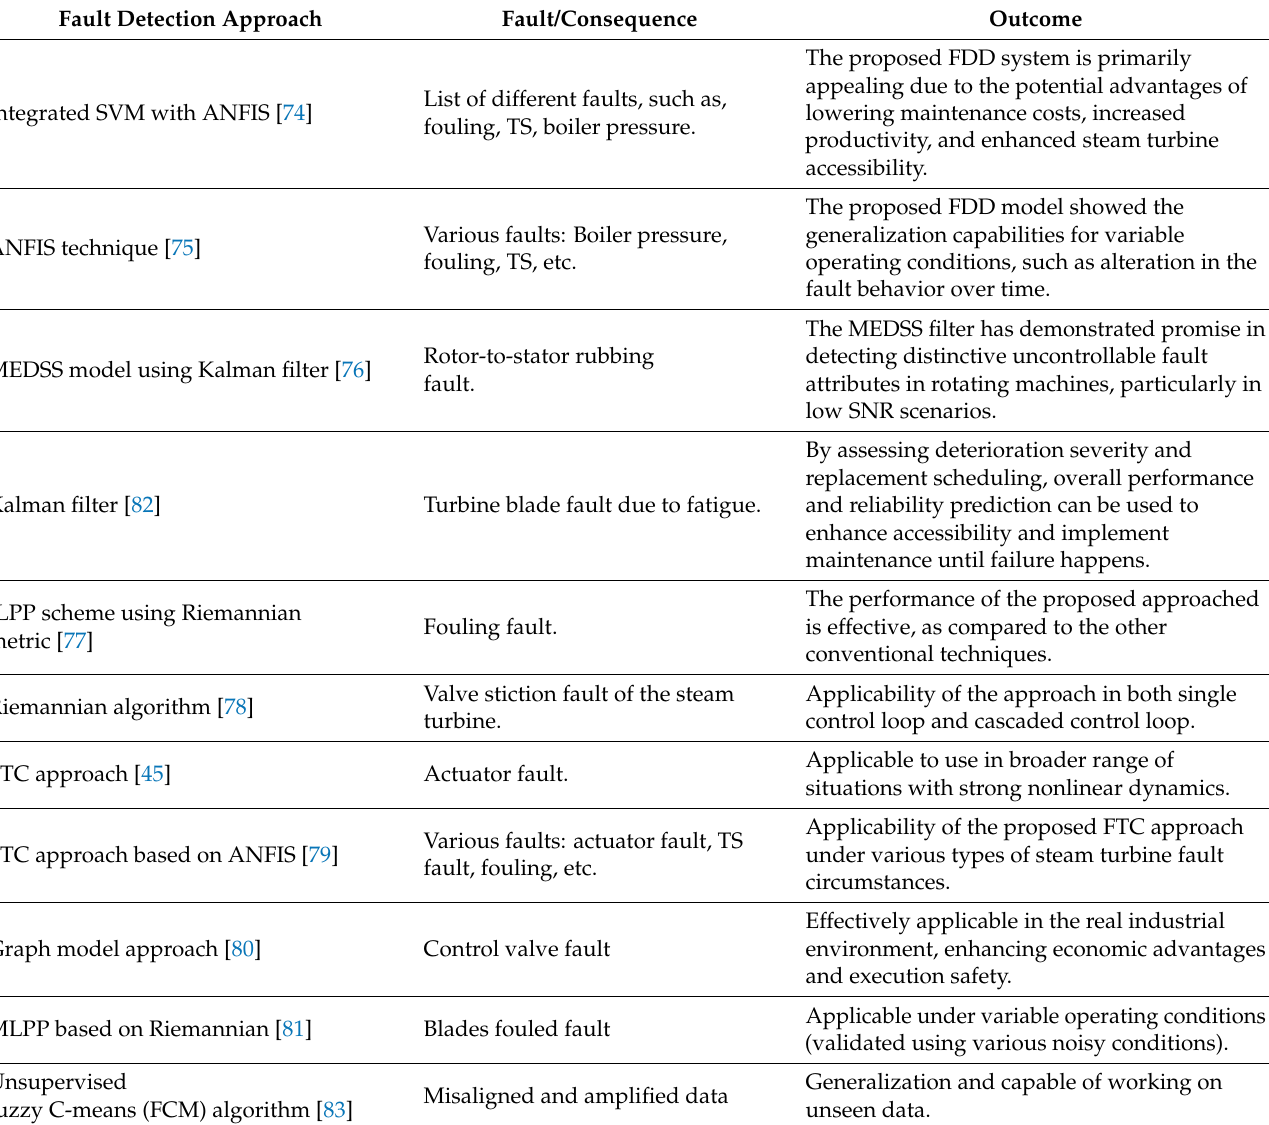
Table 1. Comparison of Model-Based Approaches for Turbine Fault Detection in Power Plant